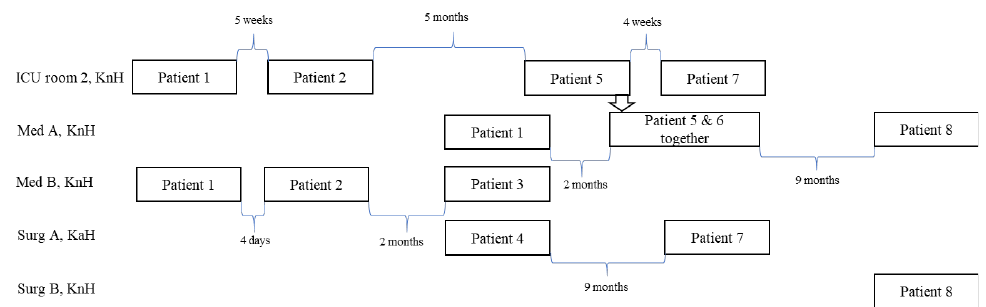
Figure 3. Wards visited by the patients involved in the outbreak. Med A and B — wards in the De- partment of Medicine, Surg A and B — ward in the Department of Surgery, ICU — intensive care unit, Department of Medicine, Surg A and B—ward in the Department of Surgery, ICU—intensive care KnH — Karlshamn hospital, KaH — Karlskrona Hospital. unit, KnH—Karlshamn hospital, KaH—Karlskrona